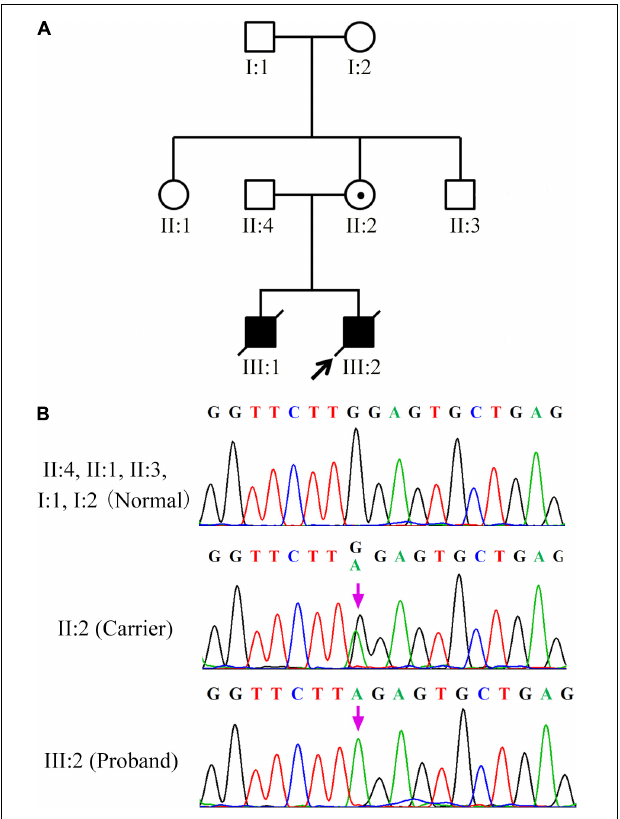
FIGURE 1 | SH2D1A mutations in patients with X-linked lymphoproliferative disease (A) Affected members indicated in the pedigree chart for a Chinese family. The arrowhead denotes the proband. (B) Sequencing result of SH2D1A of specimens collected from the family members. The purple arrows indicate the mutation site at which the premature stop codon will be